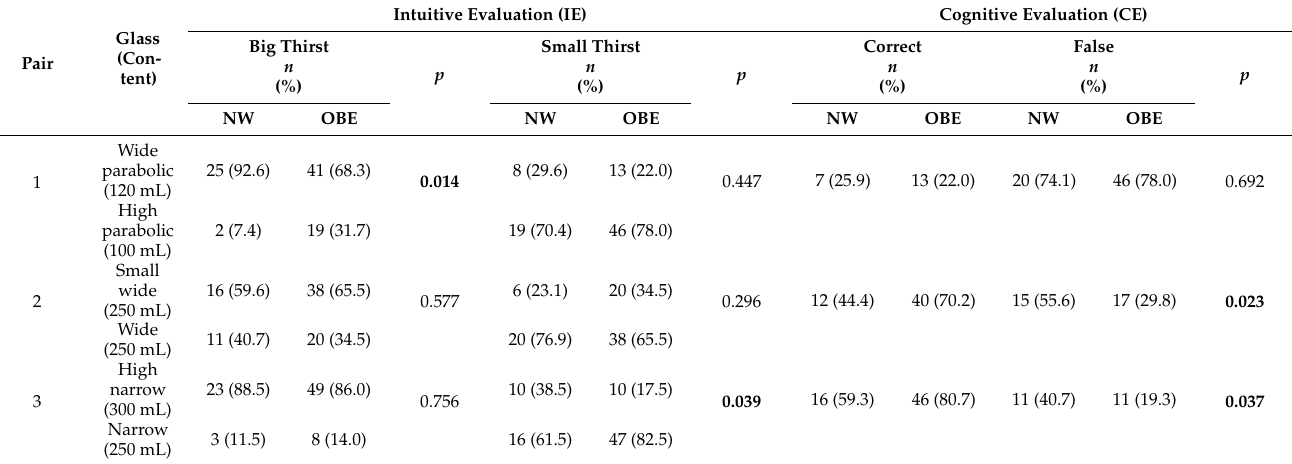
Table 3. Results of the intuitive and cognitive evaluation for drinking